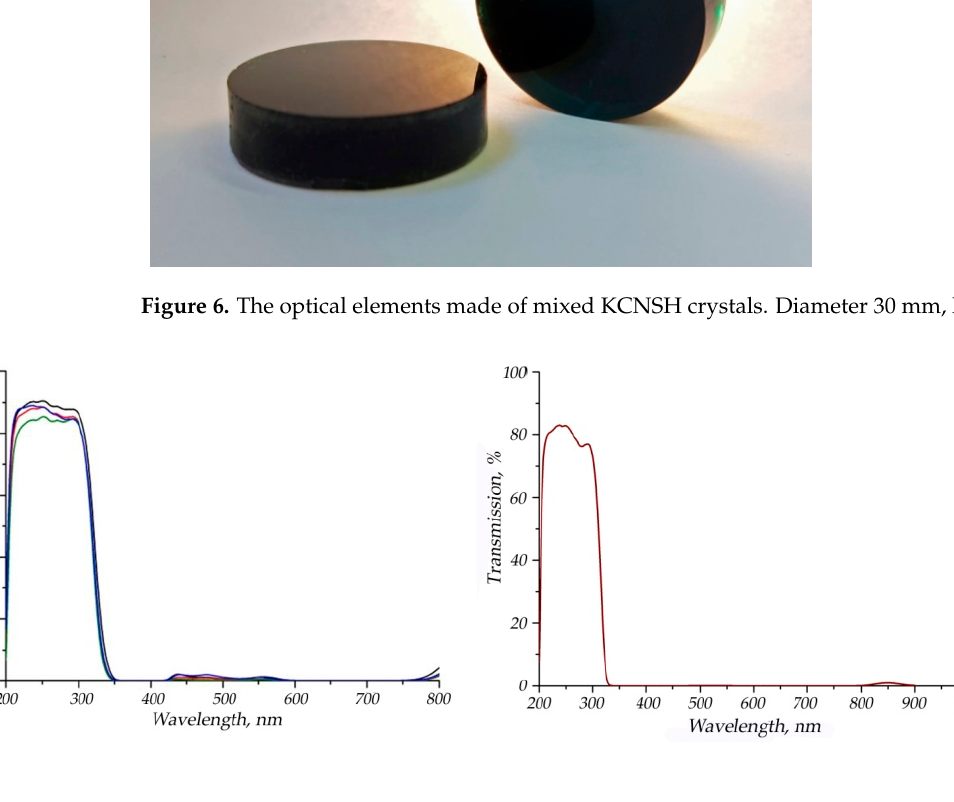
Figure 7. Optical transmission spectra of elements of KCNSH crystals with sample thickness of 10 mm ( a ) and 20 mm ( b ).